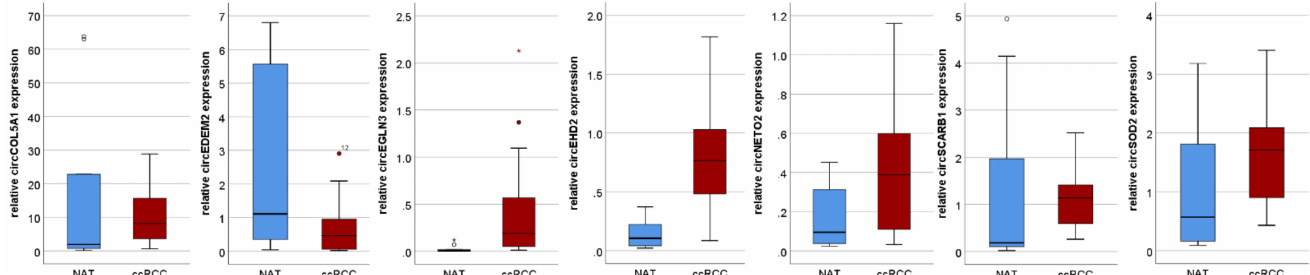
Figure 1. The expression of circEHD2, circEGLN3, and circNETO2 is increased in clear cell renal cell carcinoma (ccRCC) compared with normal adjacent renal (NAT) tissues, whereas expression levels of circSCARB1, circCOL5A1, and circSOD2 are not different in ccRCC and NAT. Circles indicate outliers.